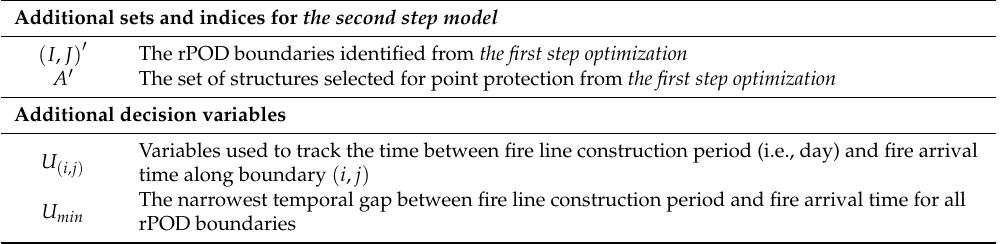
Table 2. Denotations used in suppression timing adjustments in the second step model